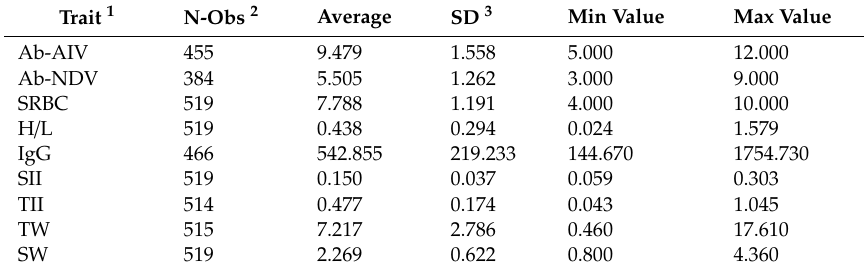
Table 1. Descriptive statistics of nine immune